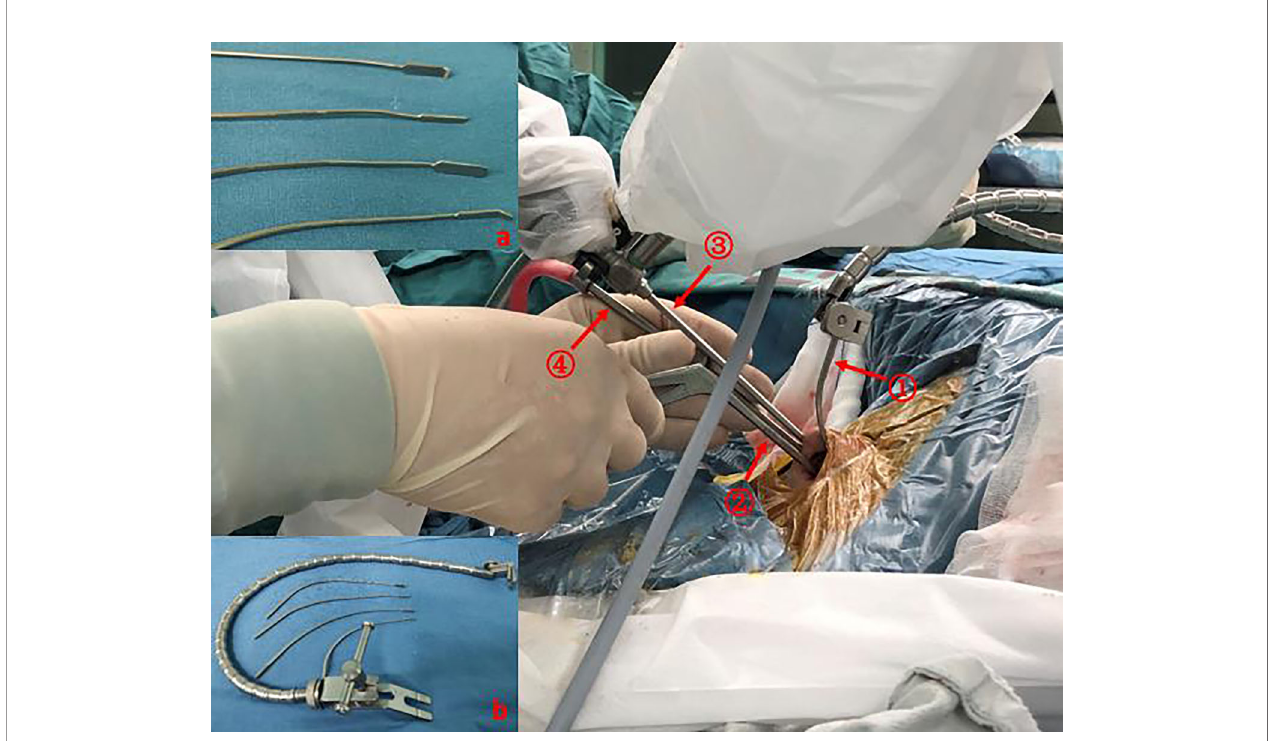
FIGURE 3 | The location of the micro retractor and the other instruments during the endoscopic endonasal approach. The micro retractor (with a self-retaining arm) and the endoscope (with a pneumatic holder) were fi xed at the 12 o ’ clock position on the nostrils. The other instruments could be manipulated bimanually free under the corridor. (A) Different lengths and widths of the micro retractor with or without serrated blades. (B) The blades were connected with a Leyla fl exible self-retaining arm. ① : Micro retractor; ② : Bayonet forceps; ③ : Endoscope; ④ :